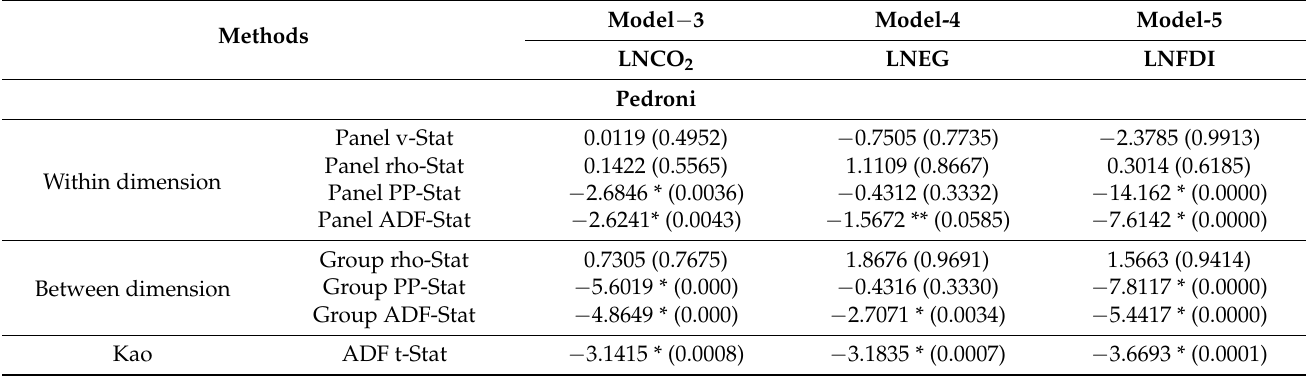
Table 7. Results of Panel Co-Integration Tests (Engle-Granger